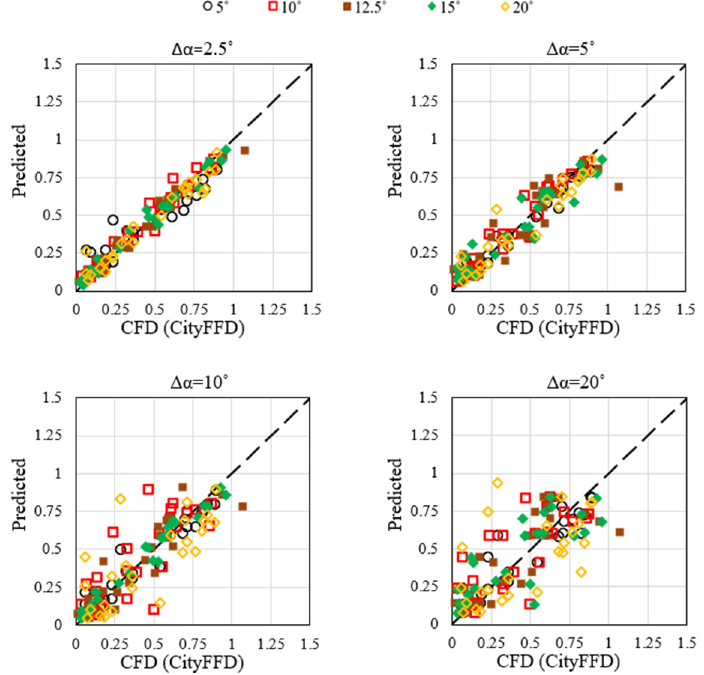
Figure 8. Wind speed predictions for different angle steps (∆𝛼 = 𝛼 (cid:3036) − 𝛼 (cid:3036)(cid:2879)(cid:2869) ) and the accuracy of ML prediction.